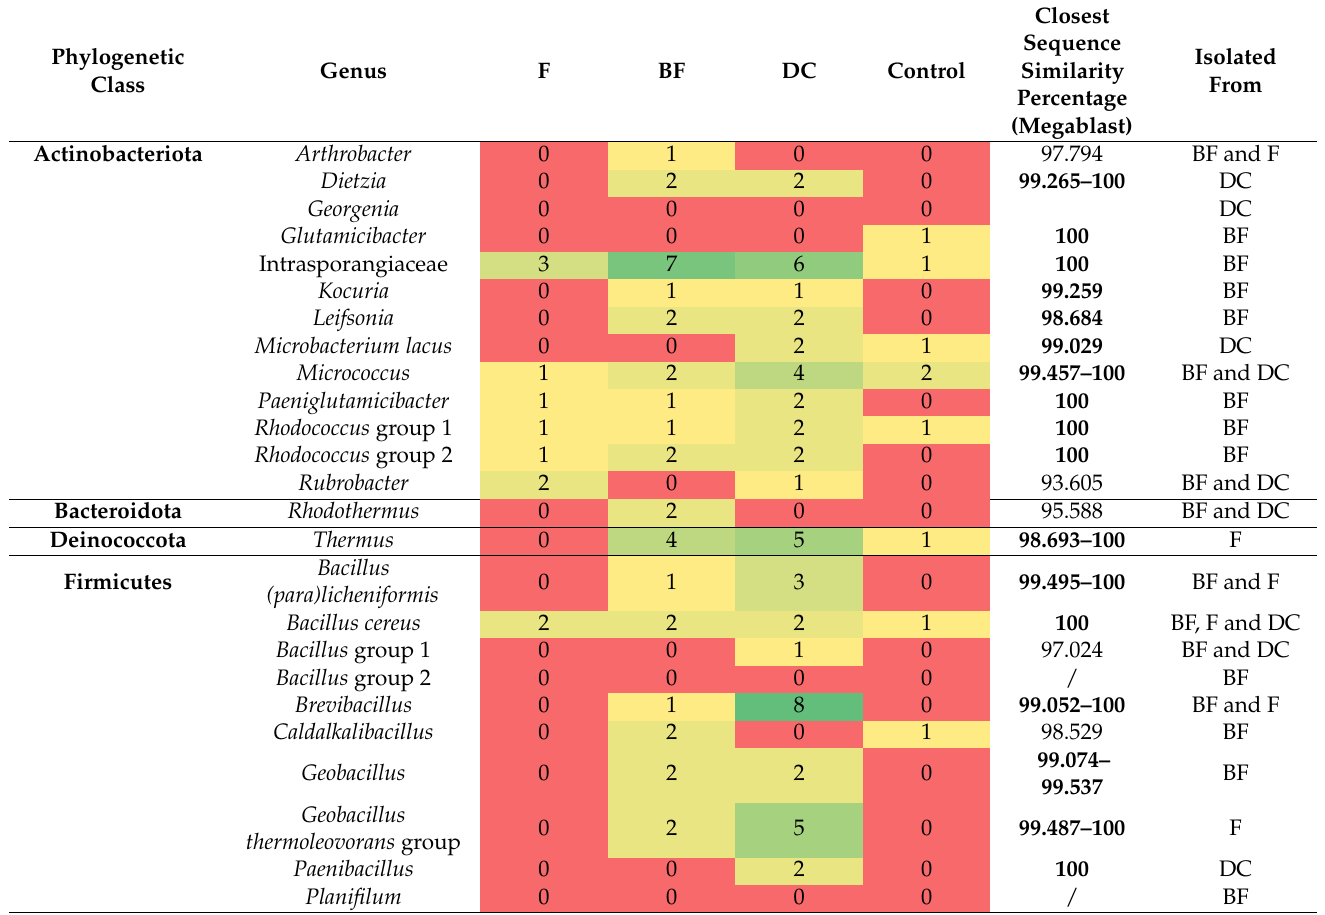
Table 3. Heatmap comparing partial 16S rRNA gene sequences from the isolated strains to ASVs from 16S rRNA amplicon gene sequencing datasets from [37] (EMBL-EBI, accession number PRJEB42339). F, Fumaroles; BF, Borehole fluids; DC, Drill cores; Control, extraction blanks. Values in bold correspond to sequence similarity percentages above 98.65%, potentially indicating that the same isolated species has been detected in the subsurface using culture-independent